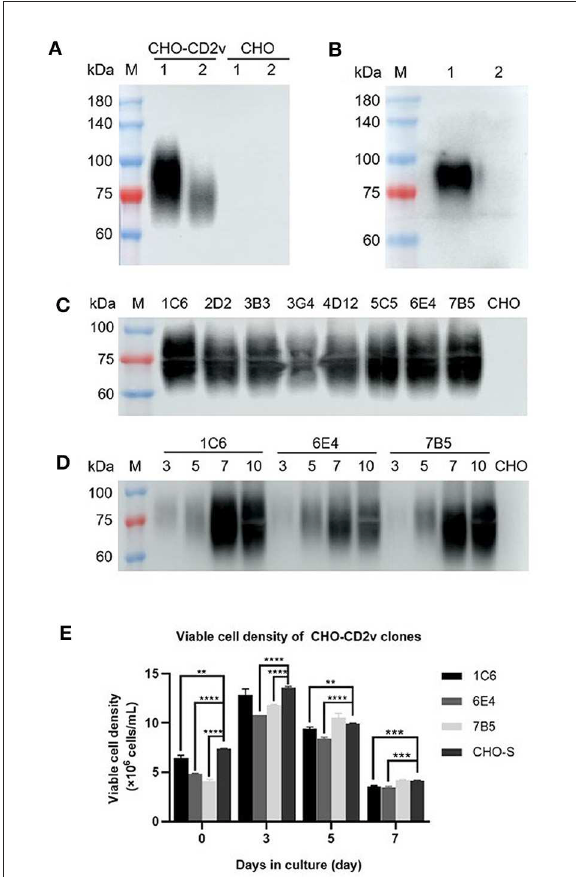
FIGURE1 Establishment of a stable CD2v-ex protein expressing cell clone. Western blot detection of CD2v-ex protein expression after transduction of CHO-S cells using an anti-His-tag antibody: Lane 1: cell culture supernatant, Lane 2: cell fragmentation supernatant (A) . Western blot detection of CD2v-ex protein expression using standard ASFV + serum (B) . Western blot comparison of expression levels of CHO-CD2v monoclonal cell lines (1C6, 2D2, 3B3, 3G4, 4D12, 5C5, 6E4, 7B5) after culture for 5 days in a 6-well plate (C) . Western blot detection of CD2v-ex protein in culture supernatants of three high-expression cell clones (1C6, 6E4, 7B5) collected on days 3, 5, 7, 10 (D) . Viable cell density of three high-expression CHO-CD2v clones after 3, 5, 7, 10 days in culture. ** p < 0.01, *** p < 0.0001, and **** p < 0.00001 (E) . Blank CHO-S cells were treated as a negative control; M: Protein marker